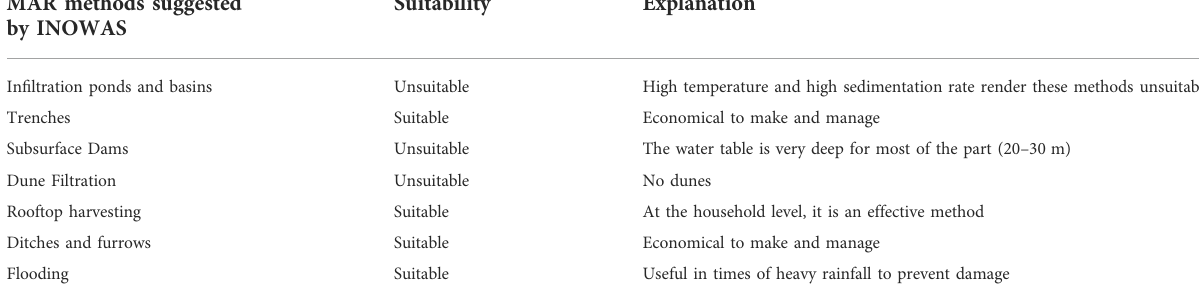
TABLE 1 MAR methods suggested by INOWAS and their suitability for the study